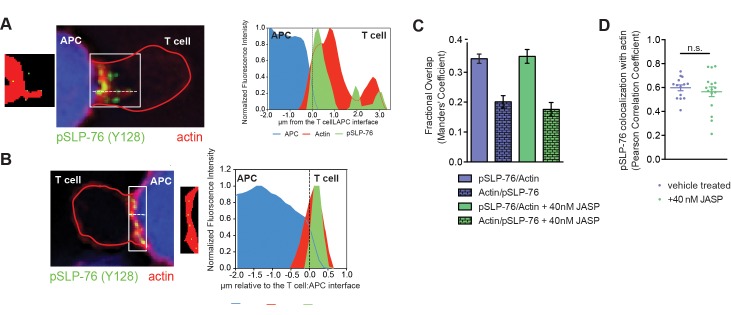
Residual pSLP-76 remains co-localized with actin upon low dose JASP treatment.(A, B) 5C.C7 T cell:CH27 APC conjugates under control conditions (A) or treated with 40nM Jasplakinolide (B) were stained for F-actin (Phalloidin), pSLP-76 (Y128), and APCs with Cell Trace Violet. The T cell outline is denoted in red. Representative images are shown on the left while intensity line scans perpendicular to the interface (dotted white line) are shown on the right. Binary masks of above background F-actin (red) are shown with the centers of mass of pSLP-76 clusters (green) next to the representative images. The clusters in the low dose JASP-treated T cell are representative of ‘APC proximal’ clusters, the clusters in the control T cell of ‘lamellal’ clusters. A is the same as Fig 6B in the accompanying manuscript. (C) Analyzing the same cell couples as in Fig 3E, Mander’s coefficient reporting the percentage of pSLP-76 that overlaps with F-actin and vise versa is given. Control data are the same as in Fig 3F of the accompanying manuscript. (D) Analyzing the same cell couples as in Fig 3E, Pearson’s correlation coefficients for colocalization of pSLP-76 with F-actin is given. Control data are the same as in Fig 3H of the accompanying manuscript. Error bars are s.e.m..